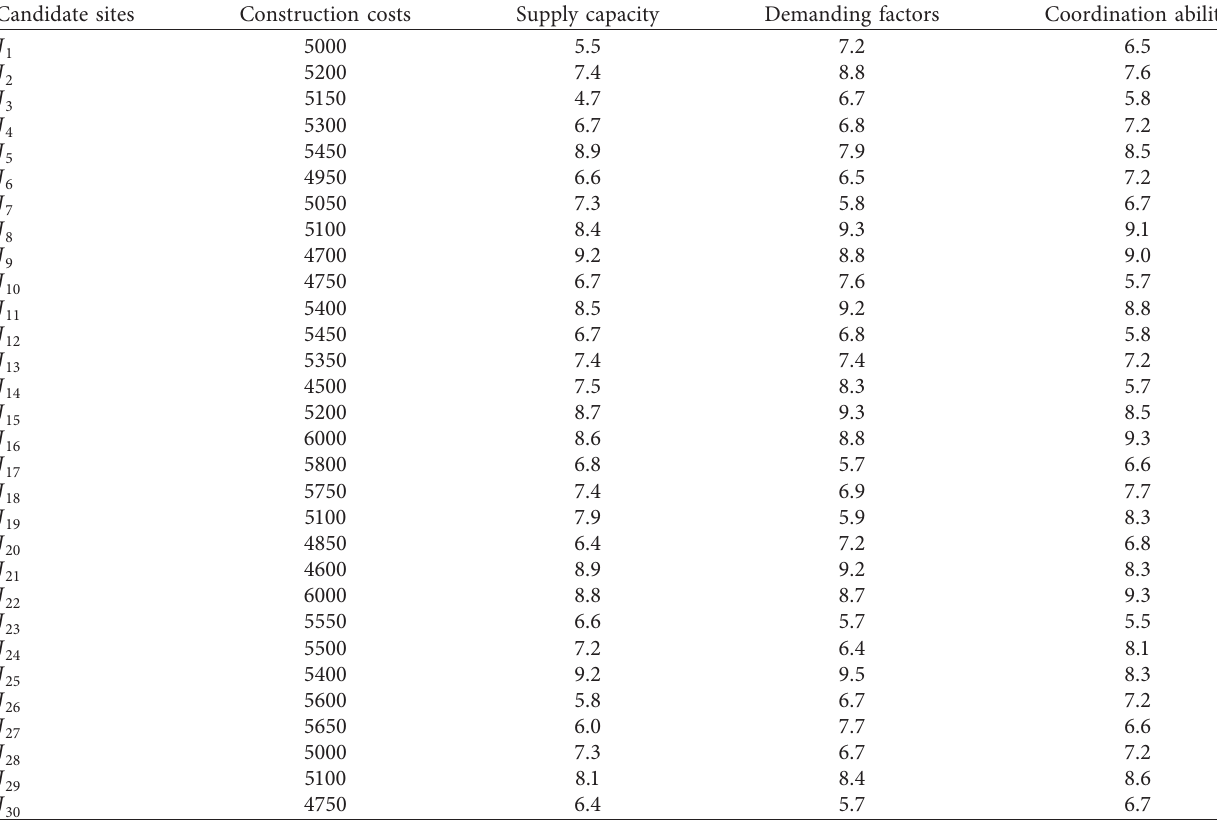
Table 1: Original data of candidate location indexes.